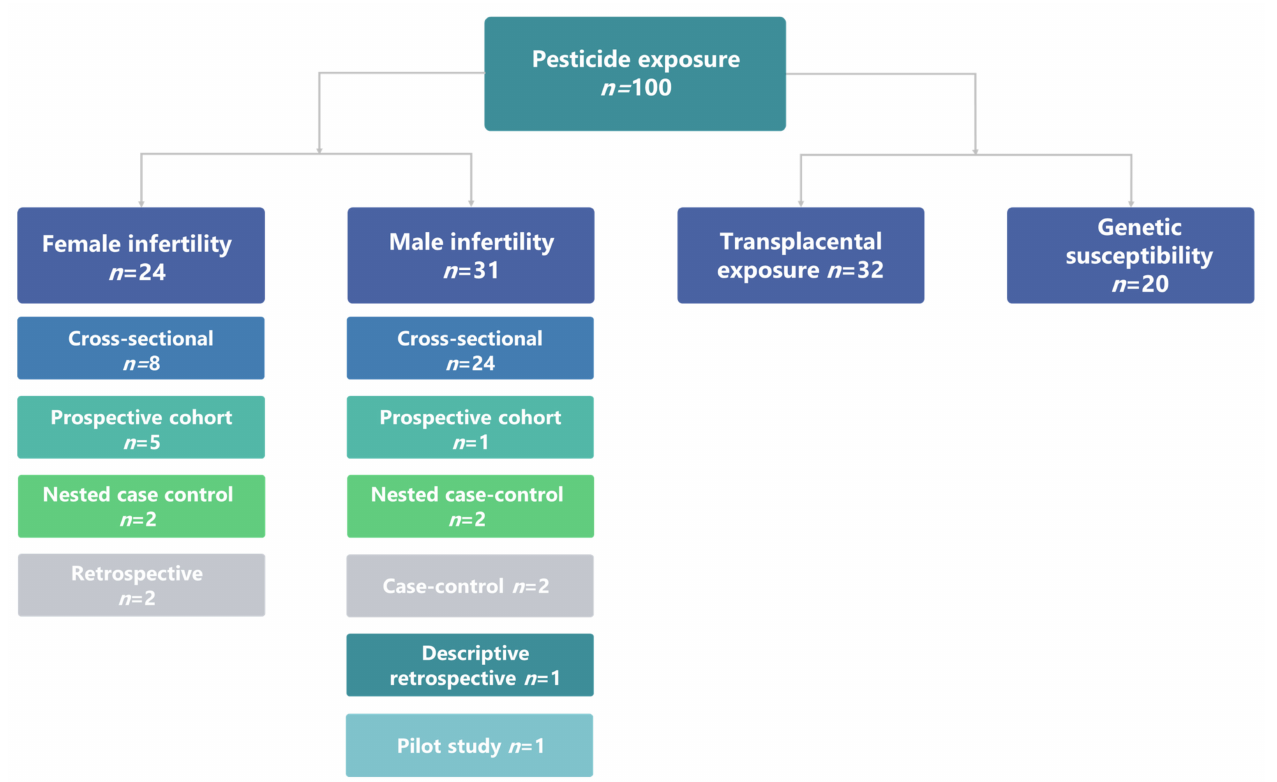
Figure 1. Graphical presentation of selected papers included in review